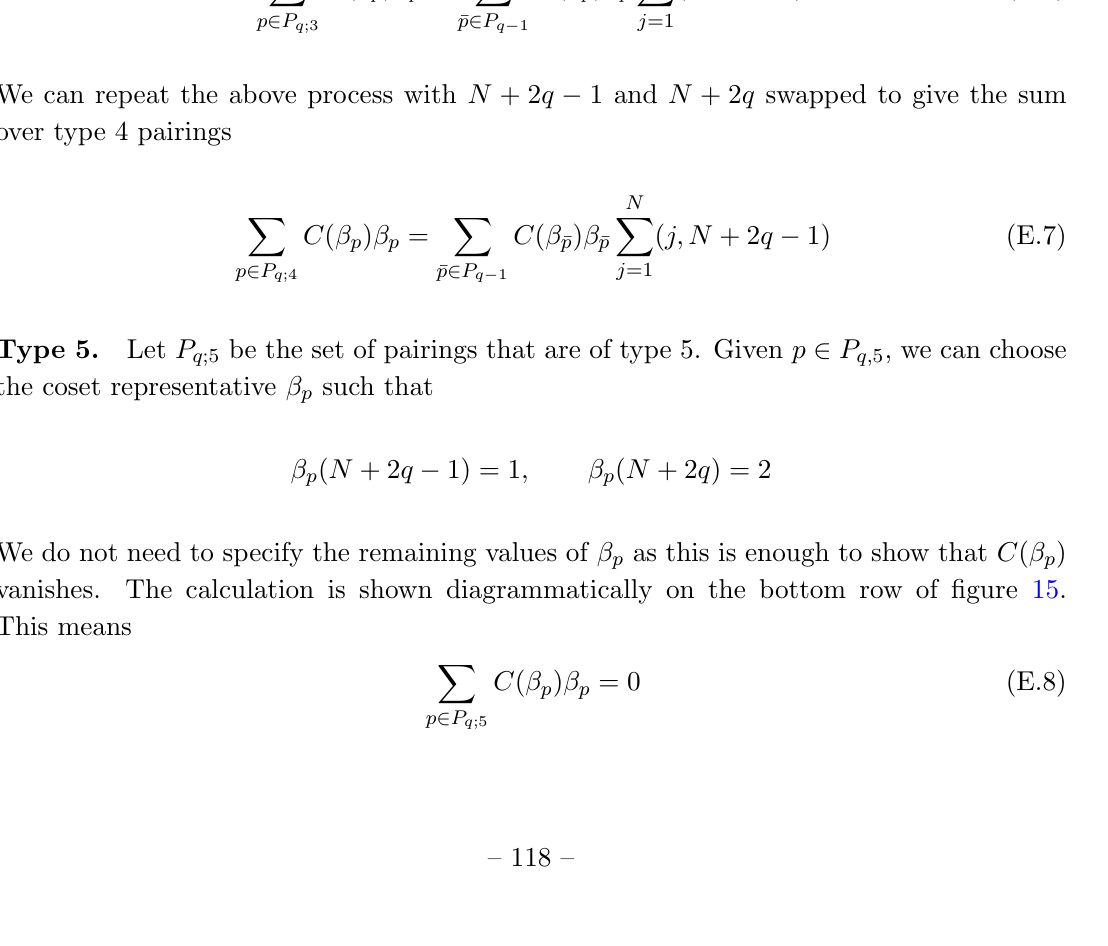
( f l g ) = f 1 ; 2 ; : : : ; N g , therefore this simpli(cid:12)es (cid:22) p i